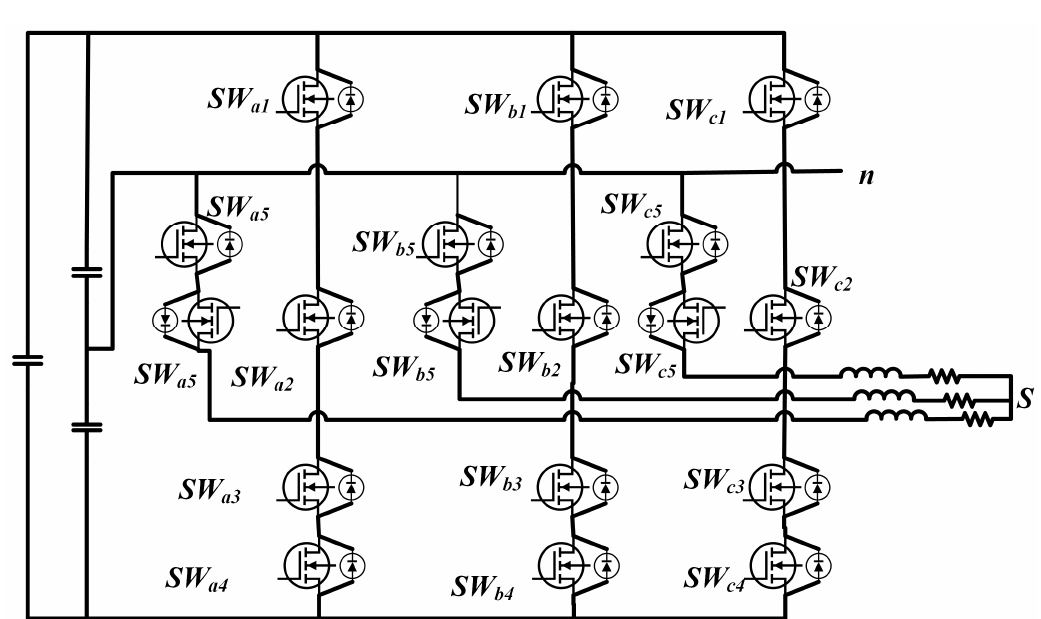
Figure 43. Dual inverter with dual sources [72]. Energies 2017 , 10 , 1217